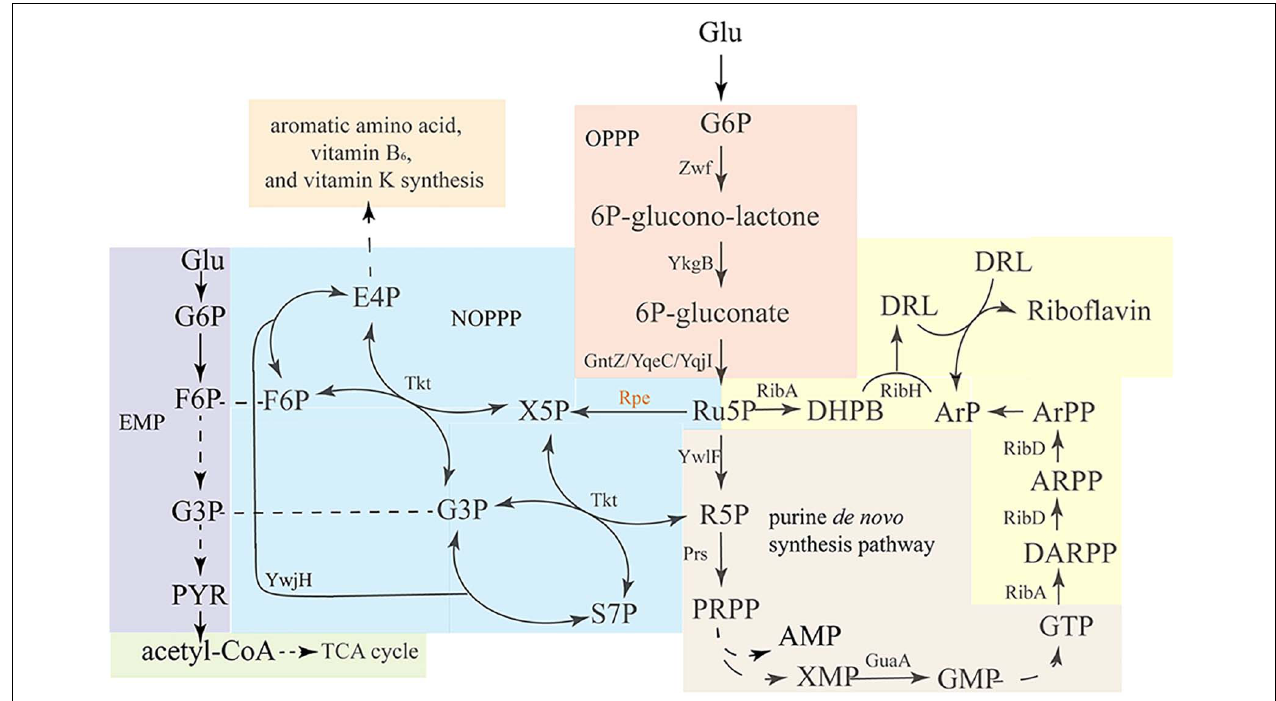
FIGURE 1 | Overview of the riboflavin biosynthesis pathway and related pathways in B. subtilis . Glucose enters the oxidative pentose-phosphate pathway (OPPP, orange), and is converted into Ru5P, which enters the purine de novo synthesis pathway (brown), which generates GTP. Ribulose-5-phosphate-3-epimerase catalyzes the interconversion of Ru5P and X5P, enabling the conversion of pentose phosphates back into F6P and G3P via transketolase and transaldolase reactions. EMP (purple) and OPPP are linked via the non-oxidative PPP (NOPPP, blue). As the precursors, GTP and Ru5P enter the riboflavin biosynthesis pathway (yellow) to generate riboflavin. Zwf, glucose 6-phosphate dehydrogenase; YkgB, 6-phosphogluconolactonase; GntZ/YqeC/YqjI, 6-phosphogluconate dehydrogenase; YwlF, ribose-5-phosphate isomerase; Prs, phosphoribosylpyrophosphate synthetase; Rpe, ribulose 5-phosphate 3-epimerase; Tkt, transketolase; YwjH, transaldolase; GuaA, GMP synthetase; RibA, GTP cyclohydrolase II/3,4-dihydroxy-2-butanone 4-phosphate synthase; RibD, 5-amino-6-(5-phosphoribosylamino)uracil reductase; RibE, riboflavin synthase (alpha subunit); RibD, riboflavin synthase (beta